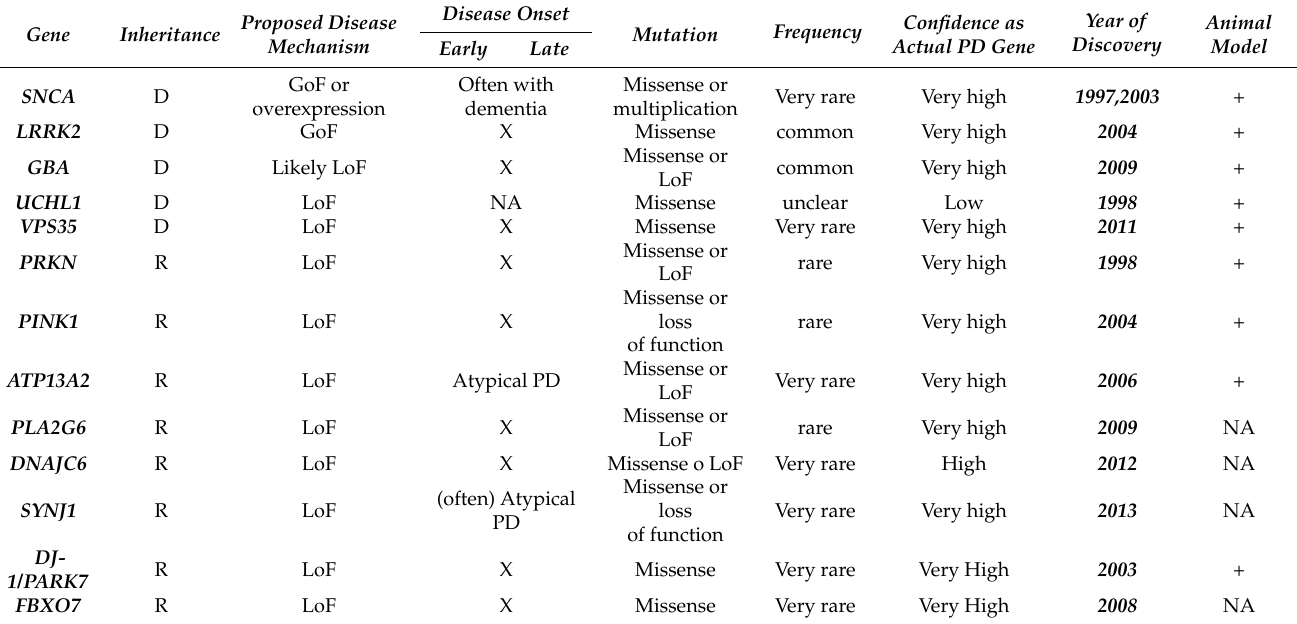
Table 1. Genes considered in this review and having mutations likely related to early-onset PD. See description of gene products in Table